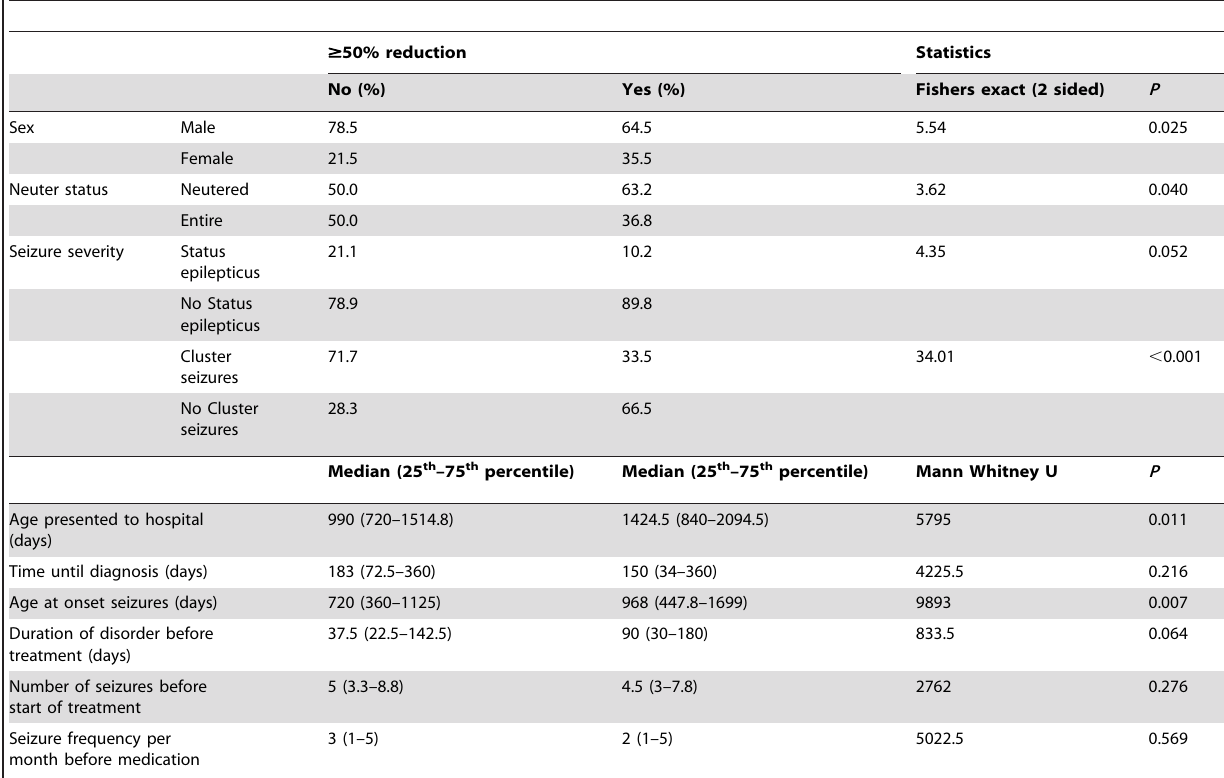
Table 2. Association between clinical variables and $ 50% reduction in seizure frequency in canine epilepsy patients.